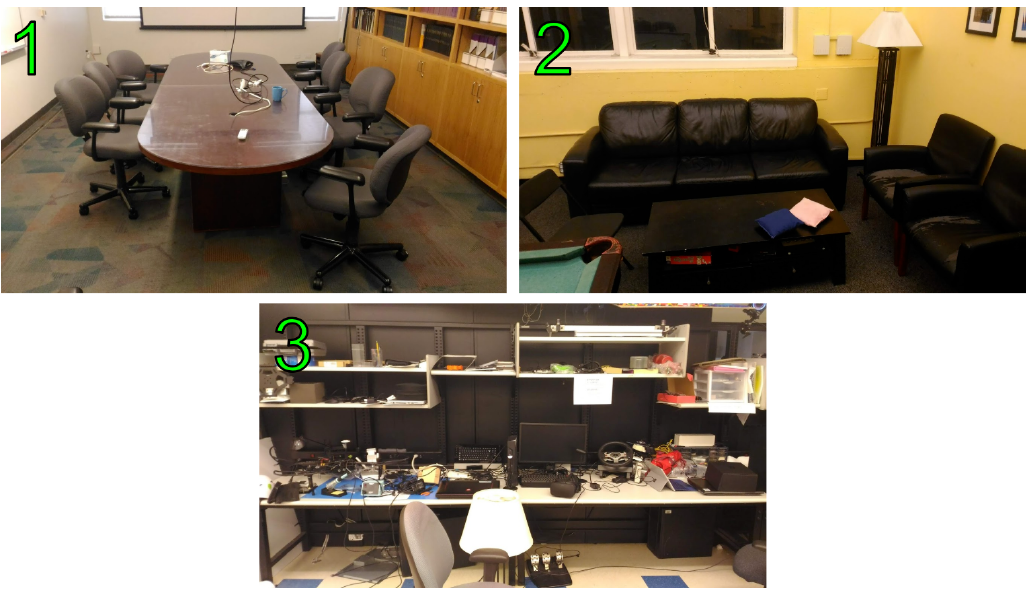
Figure A1: The three environments scanned and annotated for the study. The numbers on the picture correspond to the numbers in Tables 1 and 2.